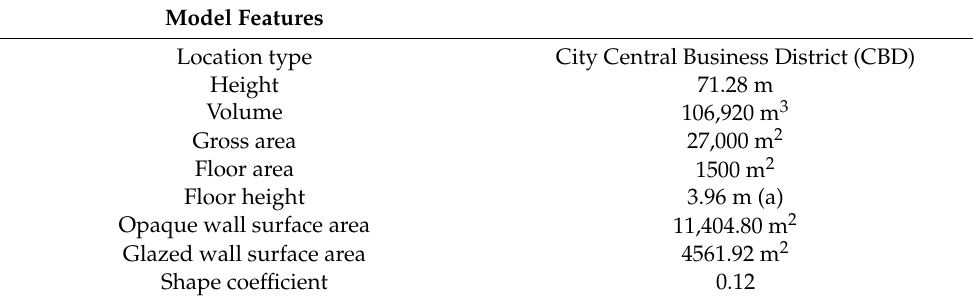
Figure 2. Standard Chinese office building model geometry: ( a ) isometric perspective; ( b ) west and south elevation. Modeled by the authors following Feng et al., description [49] (pp. 4-123 – 4-125). Table 3. Summary of the adopted standard Chinese office building prototype features [49,56].